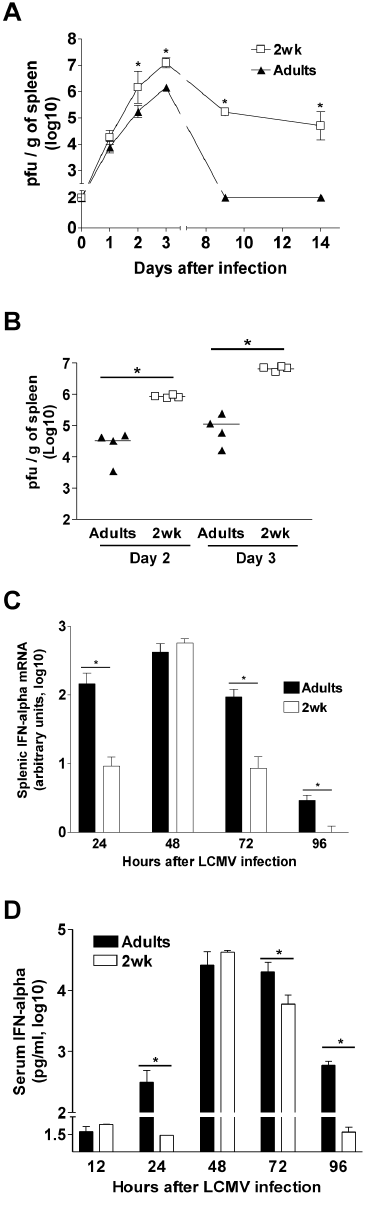
Figure 1. Impaired early viral control is associated to a delayed/shorter IFN-α burst in infant mice. (A) Spleen viral titers at different time points after infection of 2-week-old and adult mice infected i.v. with 100 pfu of LCMV-WE. One of two representative experiments is shown. *, p <0.05 versus adult mice. (B) Spleen viral titers at day 2 and 3 after infection of 2- week-old and adult mice infected i.v. with a reduced dose (10 pfu) of LCMV-WE. One of two representative experiments is shown. *, p <0.05. (C) Relative IFN-α mRNA expression quantified in the spleen at different time points after infection. One of two representative experiments is shown. *, p <0.05. (D) IFN-α titers quantified by ELISA in the serum at different time points after infection. One of three representative experiments is shown. *, p <0.05. doi: 10.1371/journal.pone.0085302.g001 PLOS ONE |